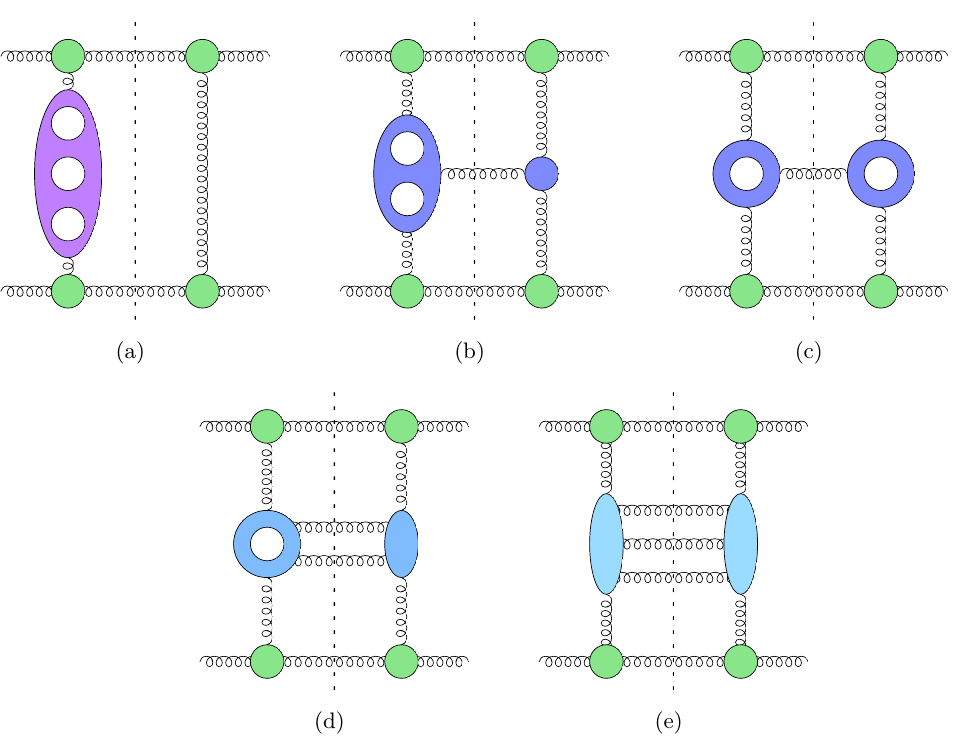
Figure 3 . Interference diagrams which contain the building blocks required for constructing the BFKL equation at NNLL accuracy: (a) gluon Regge trajectory at three loops; (b) one-gluon CEV at two loops; (c) self-interference of one-gluon CEV at one loop; (d) two-gluon CEV at one loop; (e) three-gluon CEV at tree